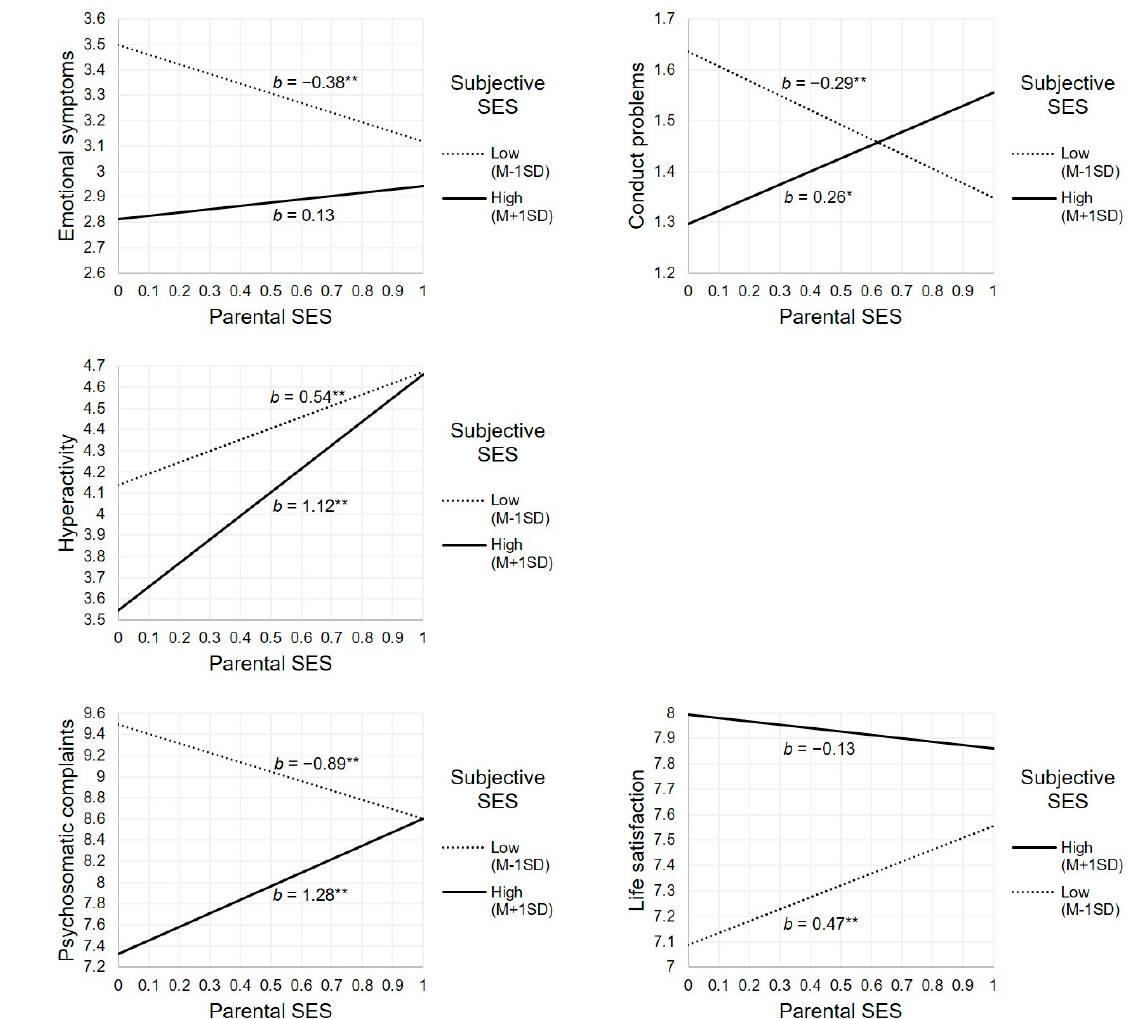
Figure 1. Conditional effect of parental SES on adolescent mental health for two values of adolescent subjective SES (Age = 13.9; Gender = female; Educational level = low). * p < 0.001, ** p < 0.0001.